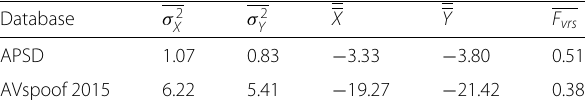
Table 1 Statistics value of F vrs on APSD and AVspoof 2015